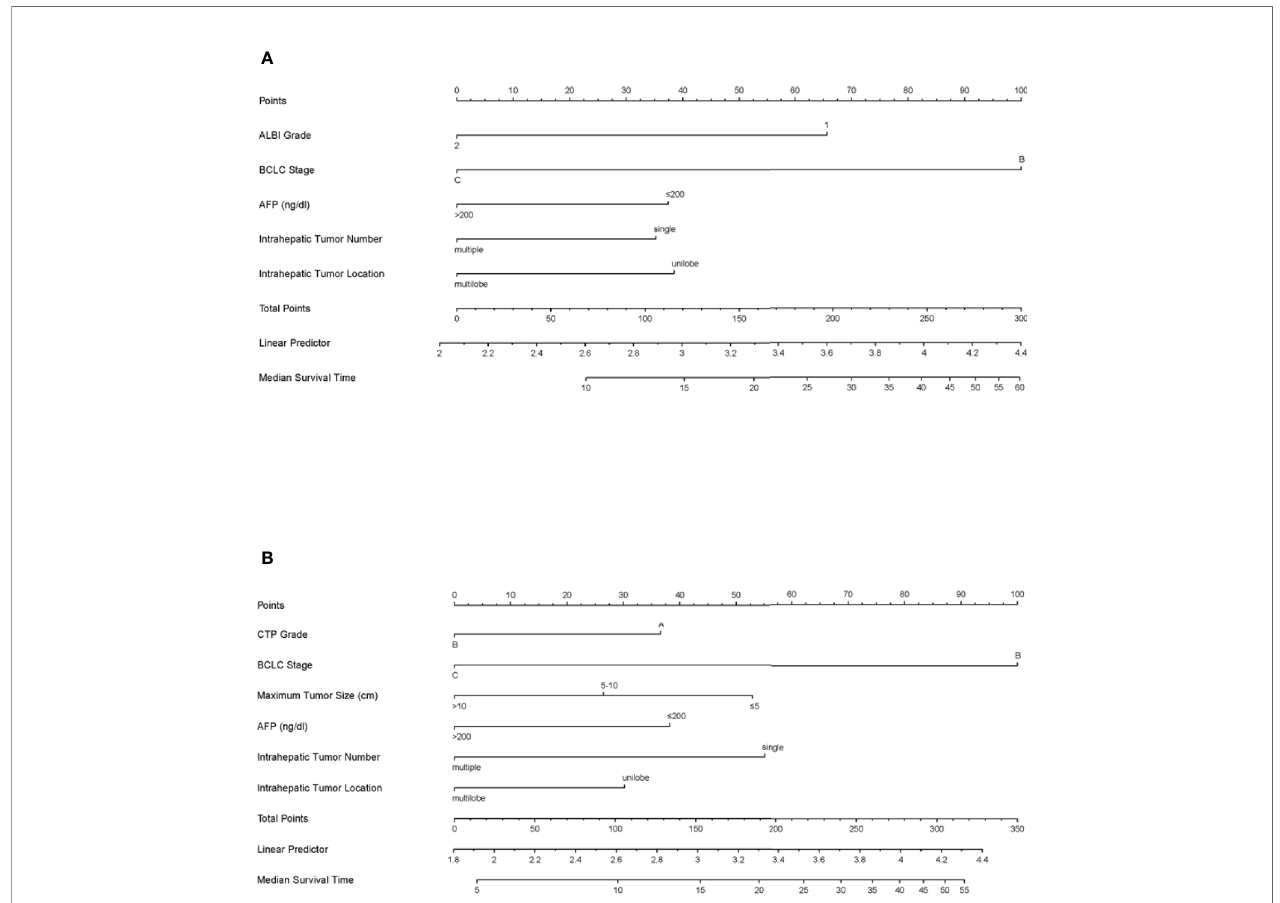
FIGURE 4 | The ALBI-based (A) and CTP-based (B) nomograms for patients with hepatocellular carcinoma after transarterial chemoembolization combined with sorafenib. ALBI, albumin-bilirubin; BCLC, Barcelona Clinic Liver Cancer; AFP, alpha-fetoprotein; CTP, Child – Turcotte –